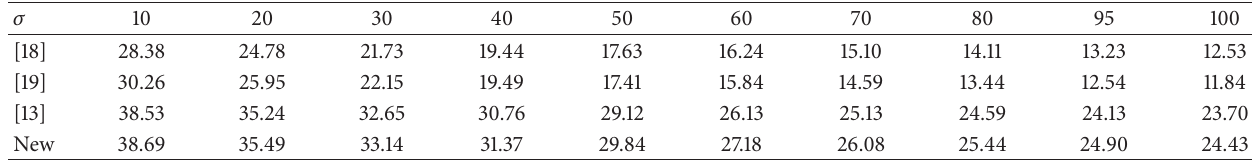
Table 3: PSNR of different algorithms with different Gaussian noise levels for Salesman video sequence.